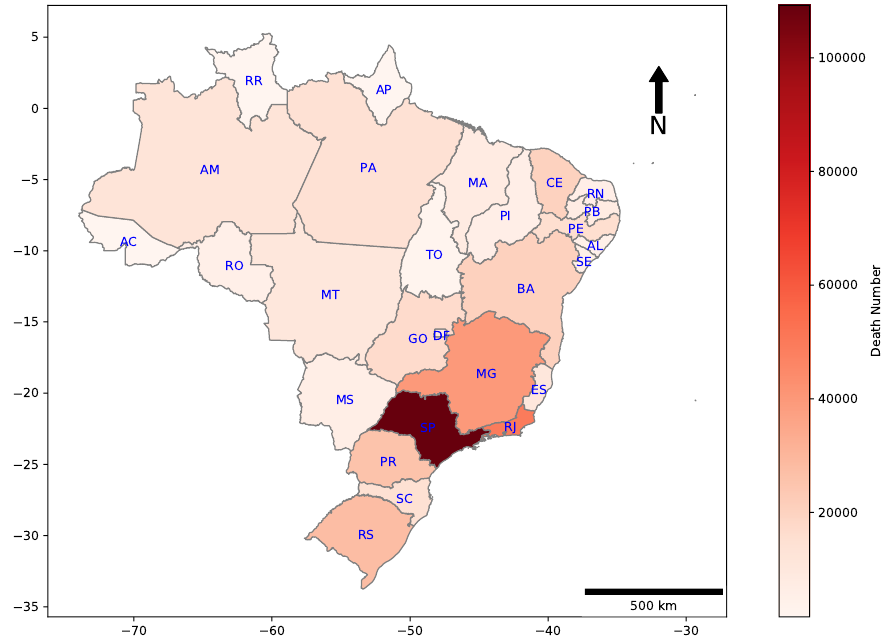
Figure 2. Heat map of cumulative deaths by COVID-19 in each Brazilian state. E.g., São Paulo, which is the most populated Brazilian state, had 109,241 deaths until the date that this research has been